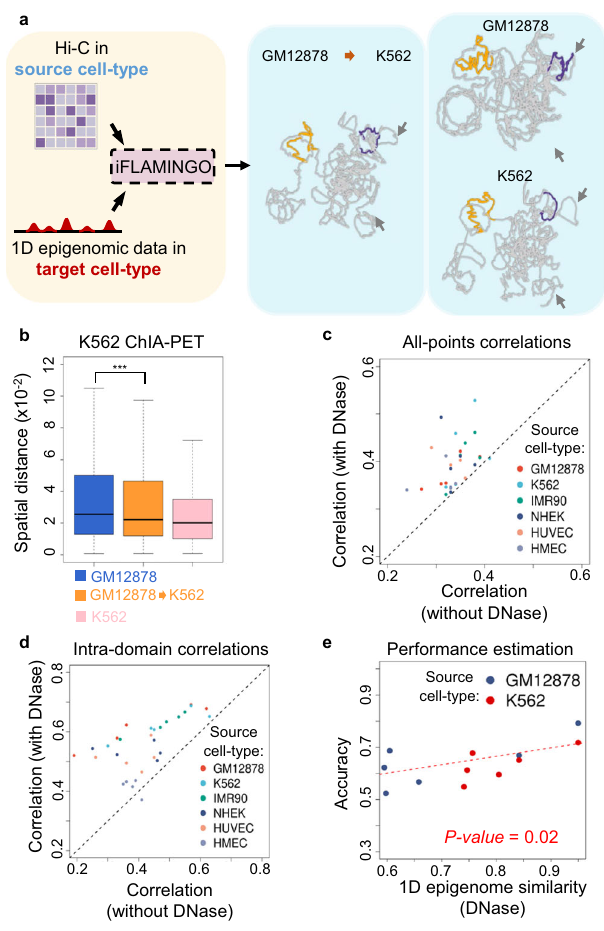
Fig. 7 Cross cell-type predictions by iFLAMINGO. a Hi-C data from the source cell-type and 1D epigenomics data from the target cell-type are integrated by iFLAMINGO to predict the 3D genome structure in the target cell-type (left). An example of the 3D structure of chromosome 21 for K562 predicted from GM12878 is shown (GM12878->K562). K562-speci fi c structural properties are highlighted by arrows where iFLAMINGO correctly captures, while the GM12878-speci fi c structure shows substantial differences. Two intra-domain structures are further highlighted in the three structures (orange and purple). b Comparison of 3D distances between interacting ChIA-PET anchors based on the predicted 3D structures of GM12878 (blue), GM12878->K562 (orange) and K562 (pink). p -value = 3.0 × 10 − 4 ( n = 1562, one-sided Mann – Whitney test). The center lines of boxplots show the median, the upper and lower box limits show the 25th and 75th percentiles respectively. The whiskers extend up to 1.5 times the interquartile range away from the limits of the boxes. Outliers outside this range were removed from the fi gure. c , d Performance comparisons between iFLAMINGO (the y -axis) and FLAMINGO (the x -axis) on cross cell-type predictions for n = 30 source-target pairs. Source-target pairs are colored by source cell-types. The performance is quanti fi ed by correlations between predicted and observed distances for all DNA fragments, i.e. all-points, in c and fragments within the same domains, i.e. intra-domain, in d . e Performance estimation (correlation of 3D distances, y -axis) for cross cell-type predictions of intra-domain structures as a function of 1D epigenomic similarities between cell-types (correlations of genome-wide DNase-seq data, x -axis). The regression line is fi tted based on cross cell-type predictions from GM12878 and K562 ( p -value = 0.02, n = 12, two-sided Student ’ s t -test). Source data are provided as a Source Data fi